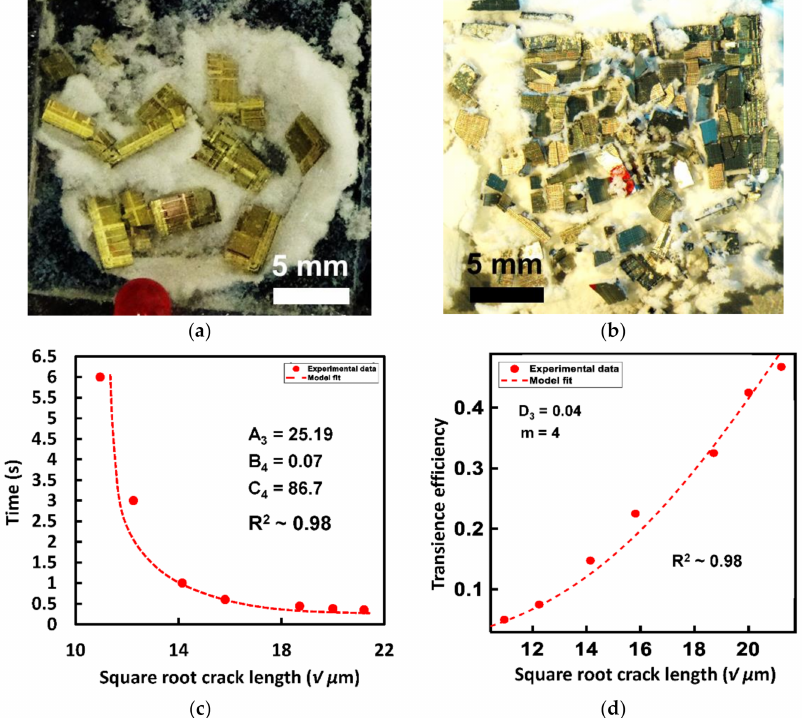
Figure 5. Post transience optical images of OTS silicon test chips for heat-triggered transience via. P4 TEP microspheres with different groove depths ( a ) 150 µ m, ( b ) 450 µ m. ( c ) Observed